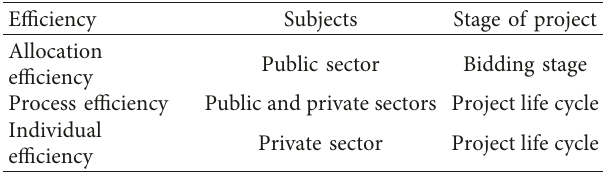
Table 1: Efficiency types and their